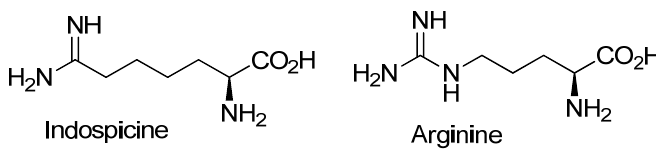
Figure 1. Indospicine an analogue of